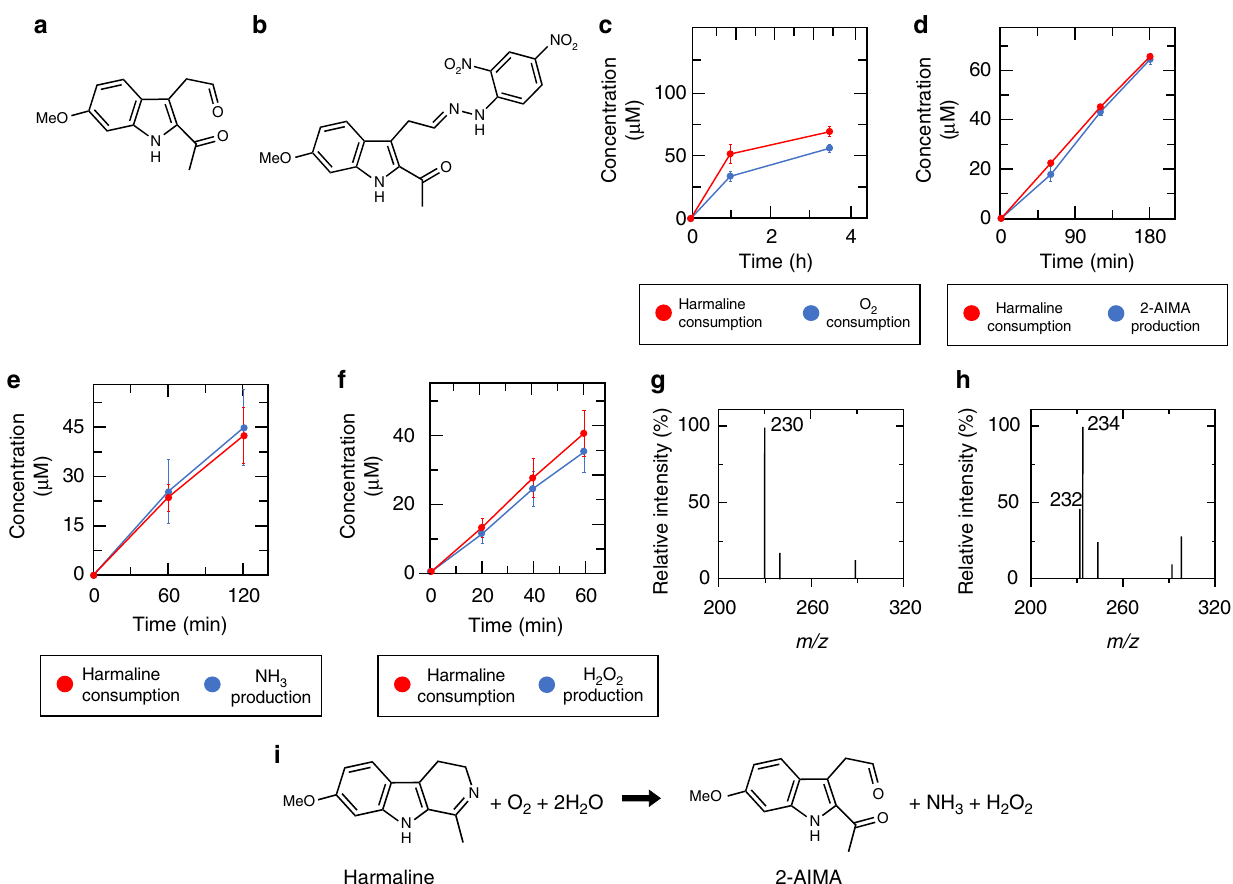
Fig. 2 Identi fi cation of the reaction formula of HarA-catalyzed reaction. The reaction products and the stoichiometry of HarA-catalyzed harmaline degradation were determined. Structures of 2-AIMA and DNPH-derivatized 2-AIMA are shown in a and b , respectively. Each of consumption of c O 2 and productions of d 2-AIMA, e NH 3 , and f H 2 O 2 were measured. They are plotted in each panel together with the amounts of consumed harmaline during the reaction under the same conditions. All the assays were performed independently under the conditions in which reaction times and enzyme concentrations were optimized for each of the detection methods. All the assays were conducted in triplicate, and all data points represent the mean values ± S.D. for three experiments. Source data are provided as a Source Data fi le. MS spectra of 2-AIMA which were synthesized in 100% H 2 16 O or 90% H 2 18 O/10% H 2 16 O are shown in g and h , respectively. i The reaction formula for HarA-catalyzed harmaline degradation. Two oxygen atoms of H 2 O 2 are derived from O